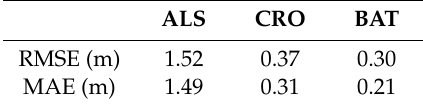
Table 8. RMSE and MAE values for WSE comparison.